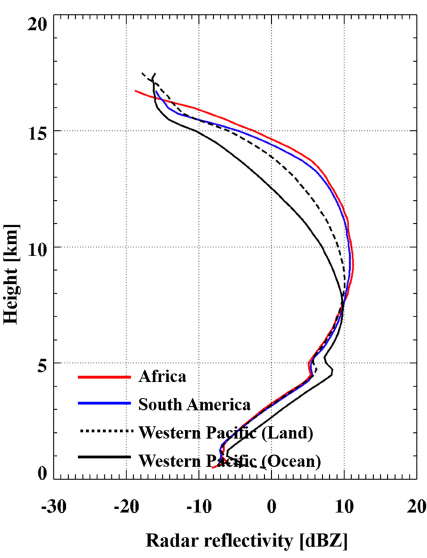
Figure 4. Average profiles of the radar reflectivity for the four anal- ysis